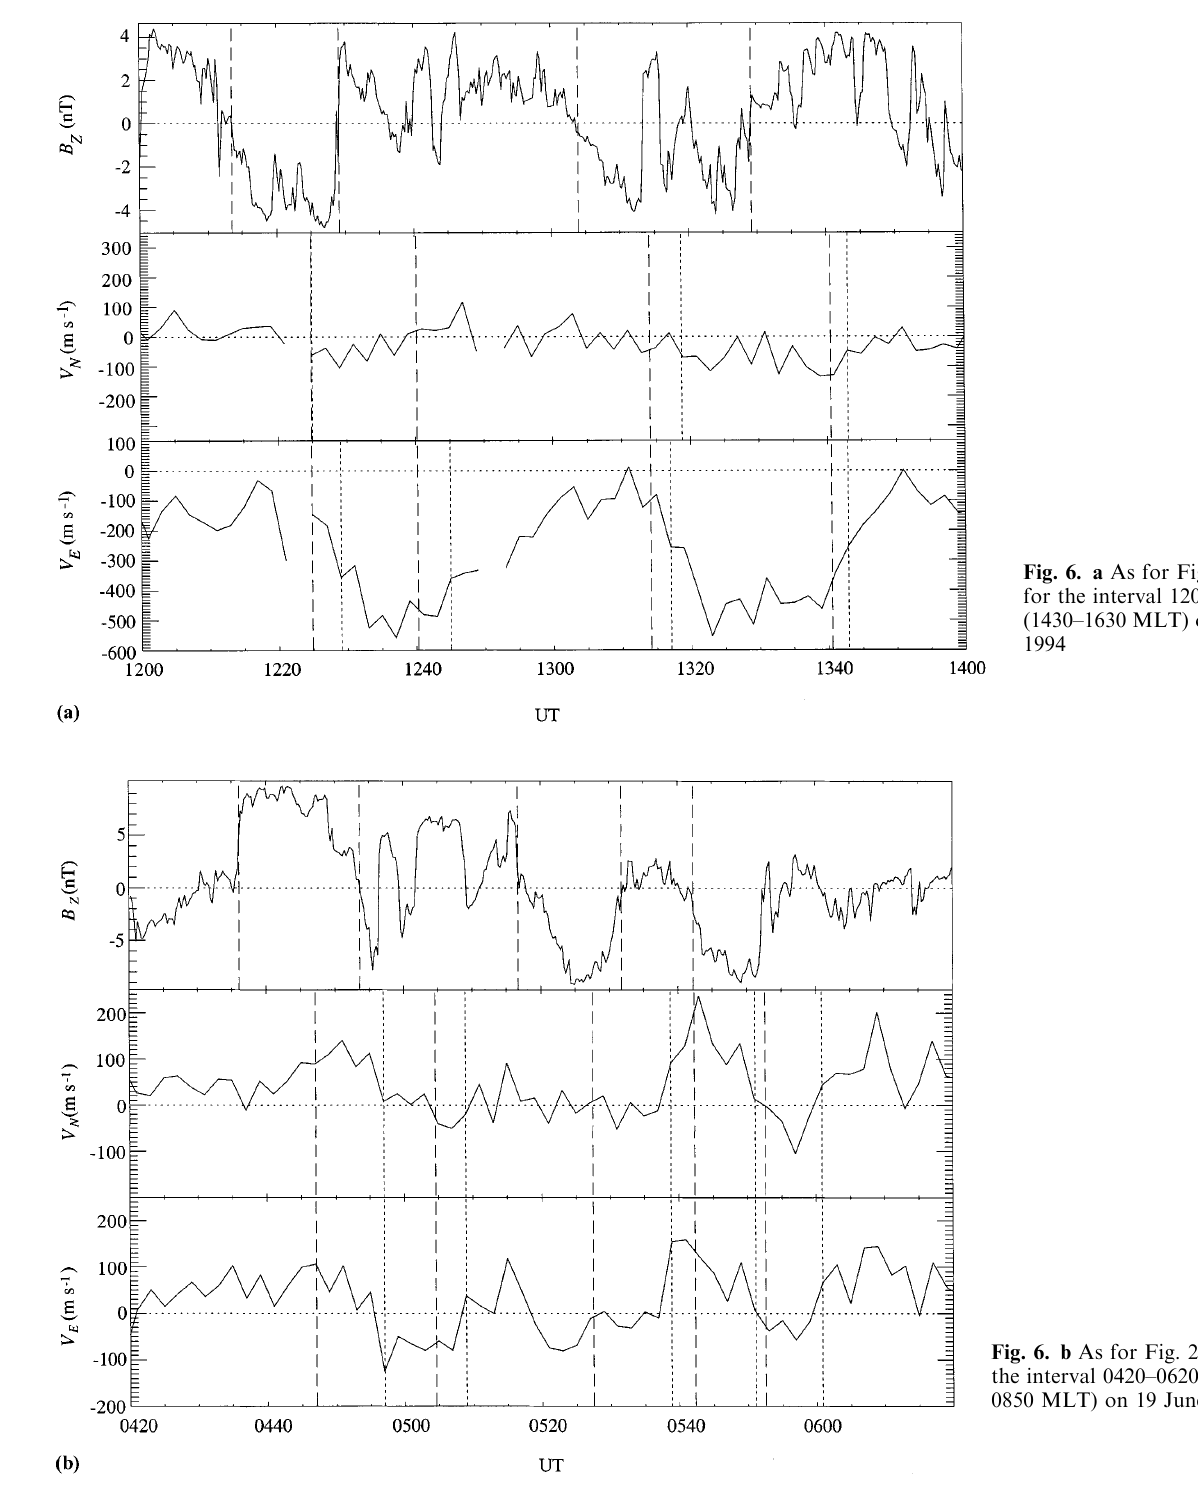
Fig. 6. b As for Fig. 2, except for the interval 0420–0620 UT (0650–